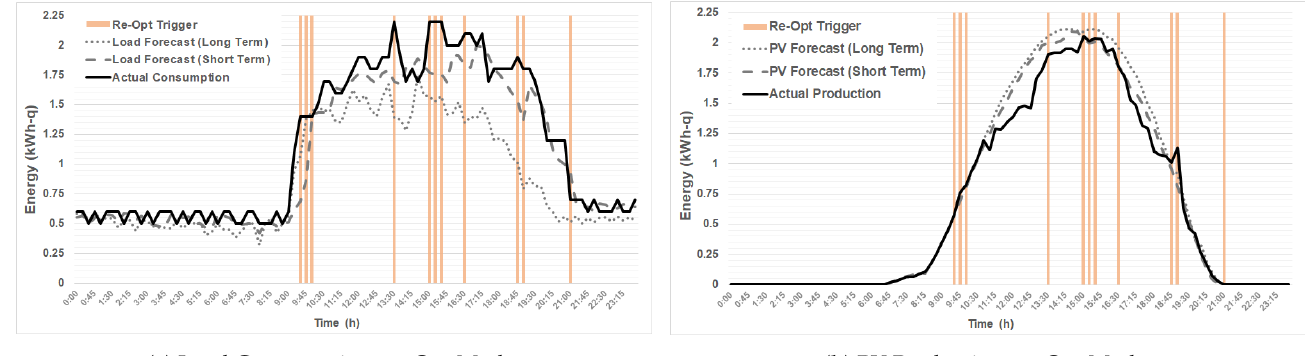
Figure 6. Scenario B—Re-optimisation mode on 22/7: